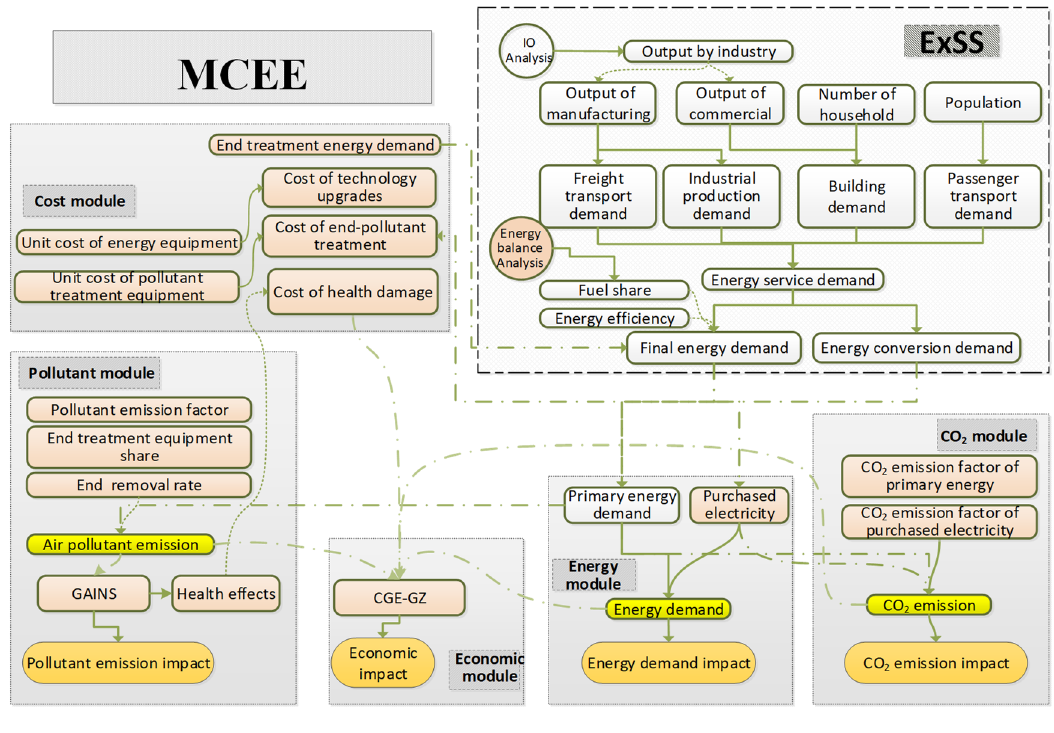
Figure 1. The structure of the MCEE model. Energies 2022 , 15 , x FOR PEER REVIEW